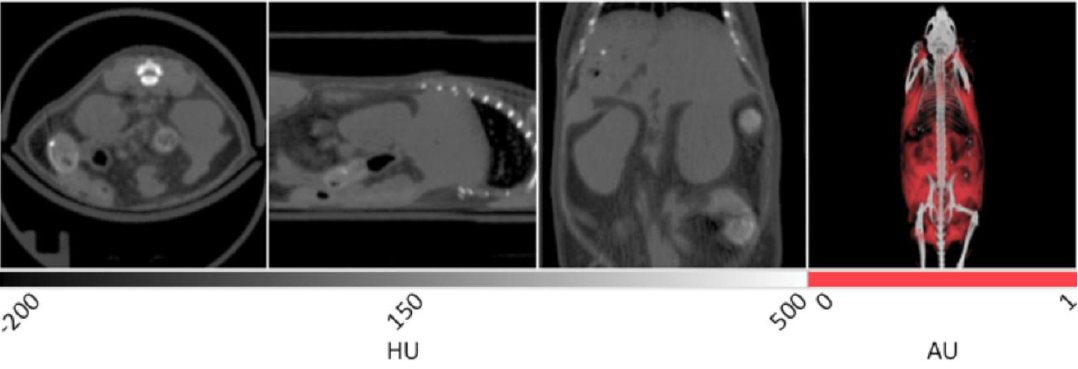
Figure 2. X-ray CT data of murine adipose tissue. In the first three panels, the visceral adipose tissue can be distinguished from the soft tissue of the kidneys and intestines due